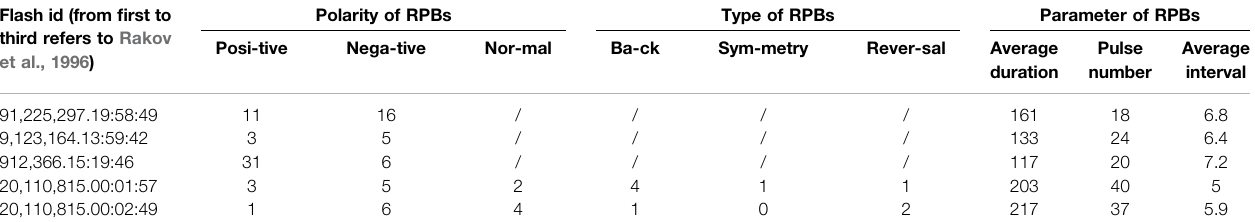
TABLE 2 | Statistical comparison of data from IC. Rows one to three are statistical data from Rokav et al., 1996; and rows fi ve to six are statistical data of IC from Qinghai. Flash id (from fi rst to third refers to Rakov et al., 1996)